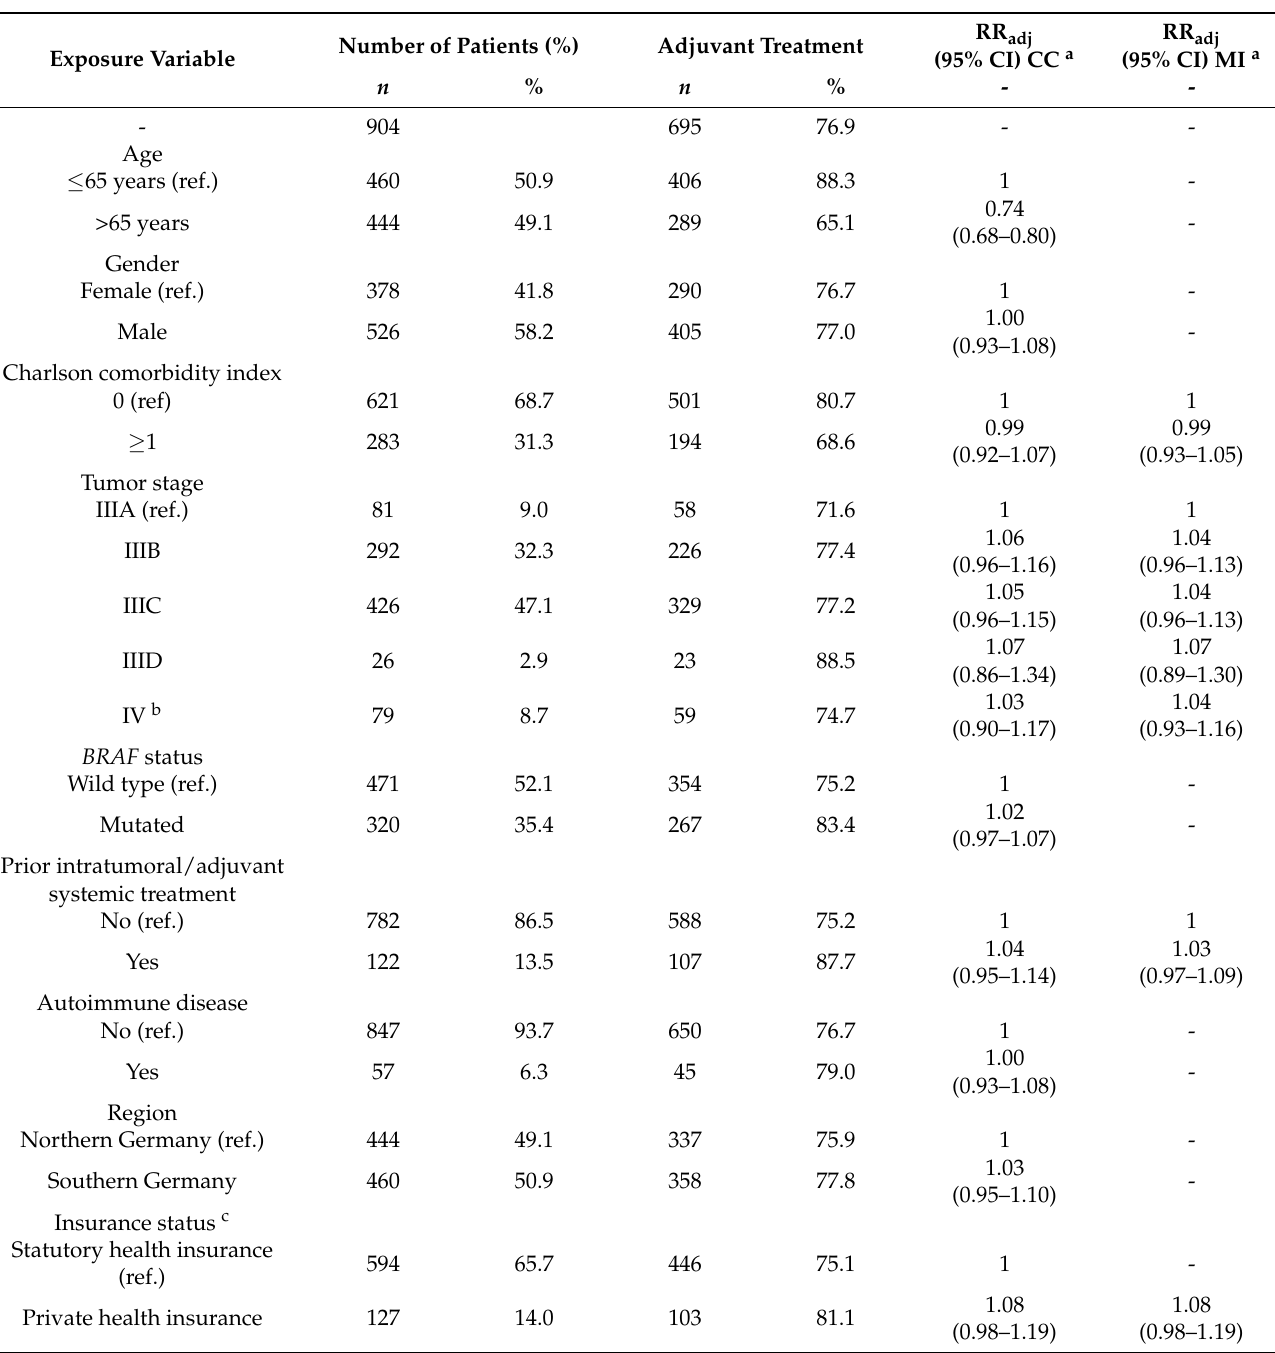
Table 3. Adjusted relative risks with 95% confidence intervals for the associations between various exposure variables and decision for adjuvant treatment: Results from log-binomial regression models with complete case analysis and use of multiple